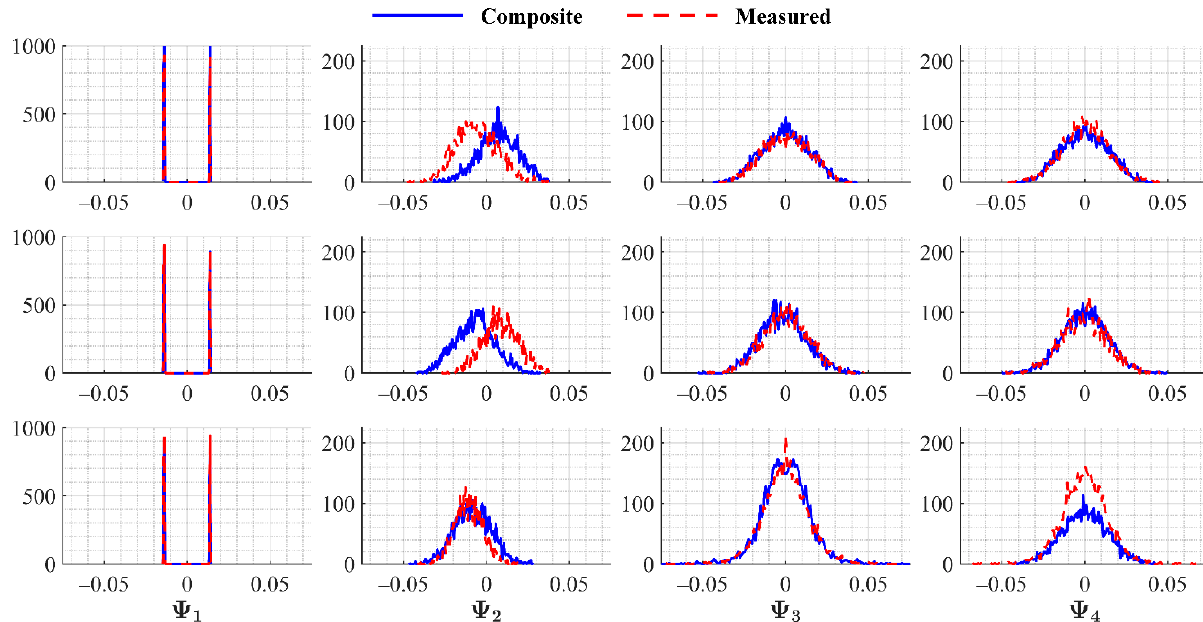
Figure 8. Histograms of the temporal loading distributions for composite and measured data for the first four modes of each velocity ratio (rows, top to bottom: V j /U ∞ = 0.9, 1.25,